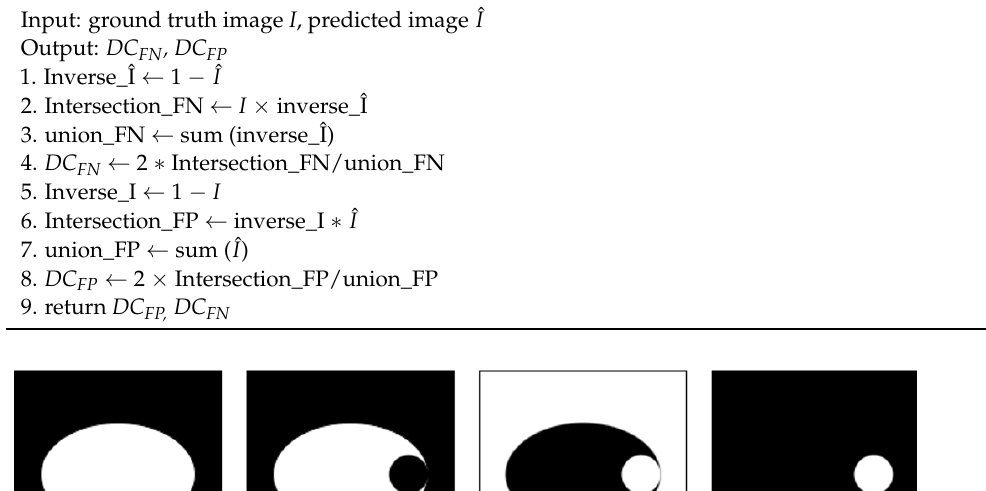
Algorithm 1 Computation of dissimilarity coefficient for false negative DC FN and false positive DC FP